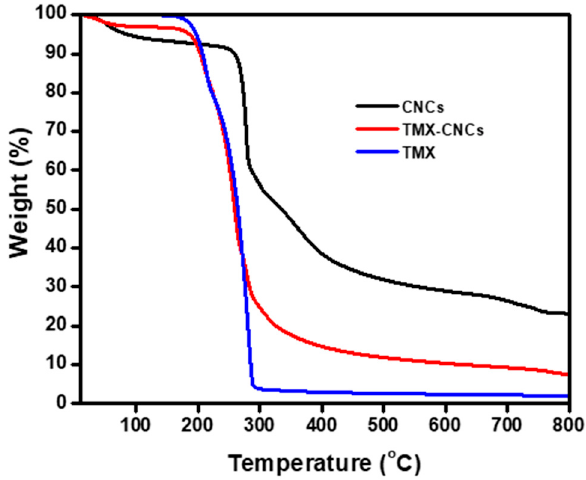
Figure 6. Thermogravimetric Analysis (TGA) curves for CNCs, TMX-CNCs and TMX.